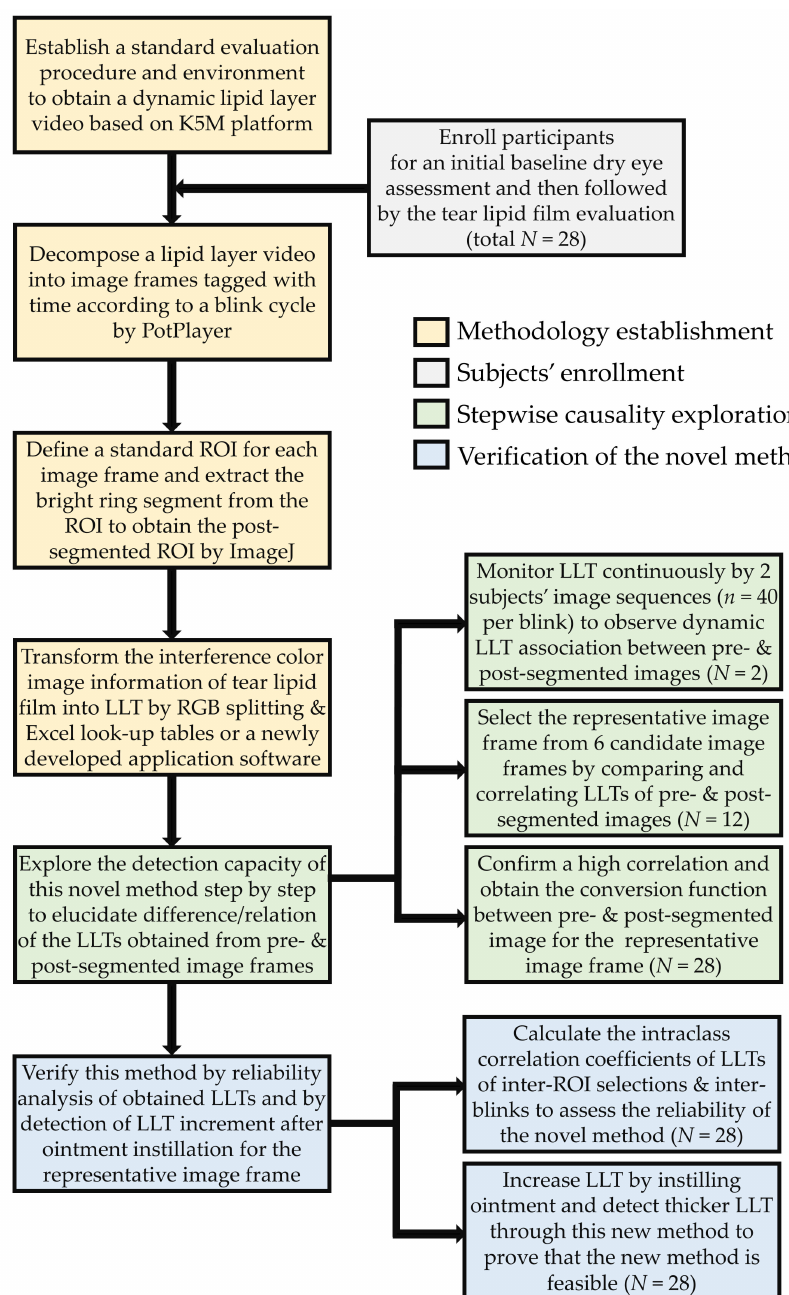
Figure 1. The flowchart of the experimental framework of this study. This experiment consisted of 4 parts, including the methodology establishment based on the K5M tear film analyzer, enrollment of subjects with dry eye symptoms, exploration of the causality of pre- and post-placido-disk ring segmented images for further selection of the representative image frames, and verification through examining the repeatability of acquired LLTs in two repeated ROI selections and two di ff erent blink cycles in a test and detecting the increment of LLT one hour after ointment instillation for each subject. K5M = Keratograph ® 5M, Oculus; ROI = region of interest; LLT = lipid layer thickness; RGB = red, green, and blue